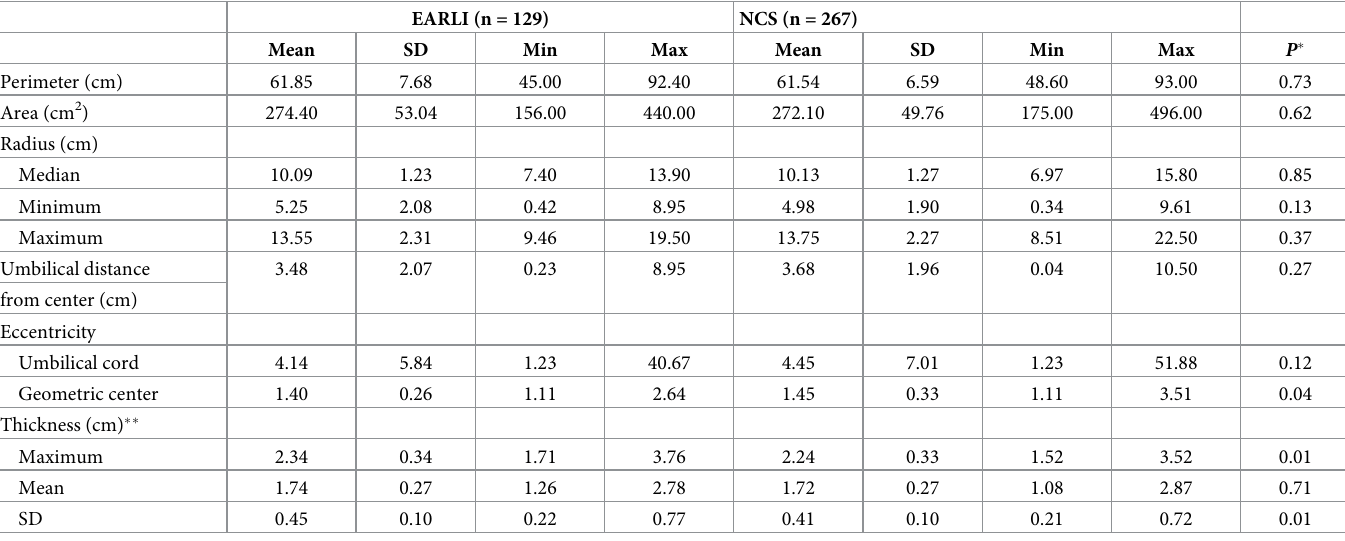
Table 4. Comparison of placental shape measures between EARLI and NCS using the Wilcoxson rank-sum